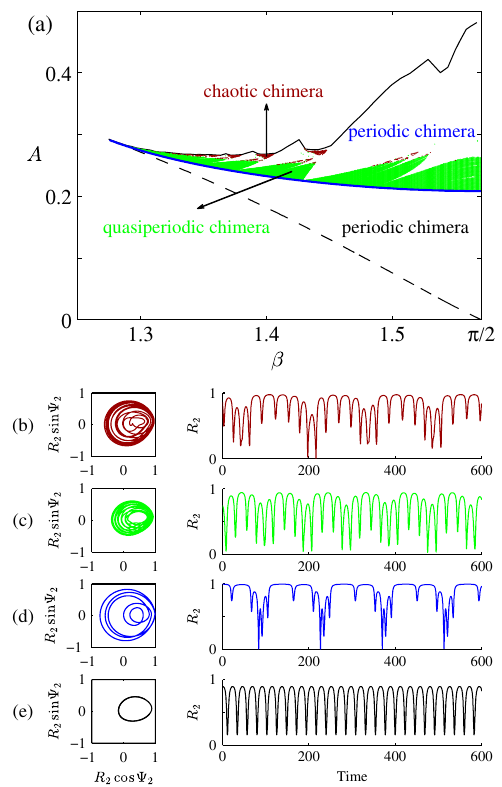
FIG. 3 (color online). (a) Location of different chimera types in the ð β ; A Þ plane for σ ¼ 0 , n ¼ 1 , and S ¼ 0 . 5 (similar results are obtained in a wide range of σ , S , and n ). Chimeras exist between the dashed line (the locus of a saddle-node bifurcation of limit cycles) and the solid line (corresponding to both the boundary crisis [46,47] and the saddle-node bifurcation of cycles). Above the thick (blue) line, quasiperiodic and chaotic chimeras are found in the light (green) and dark (red) shaded regions, respectively. (b) – (e) Trajectories projected onto R 2 e i Ψ 2 and R 2 ð t Þ for the parameter values with distinct behaviors: ð β ; A Þ ¼ ð 1 . 4 ; 0 . 265 Þ , (1.42, 0.24), (1.5,0.35), and (1.45,0.19) from (b) to (e), corresponding to chaotic, quasiperiodic, and periodic chimera states above and below the thick (blue) line,